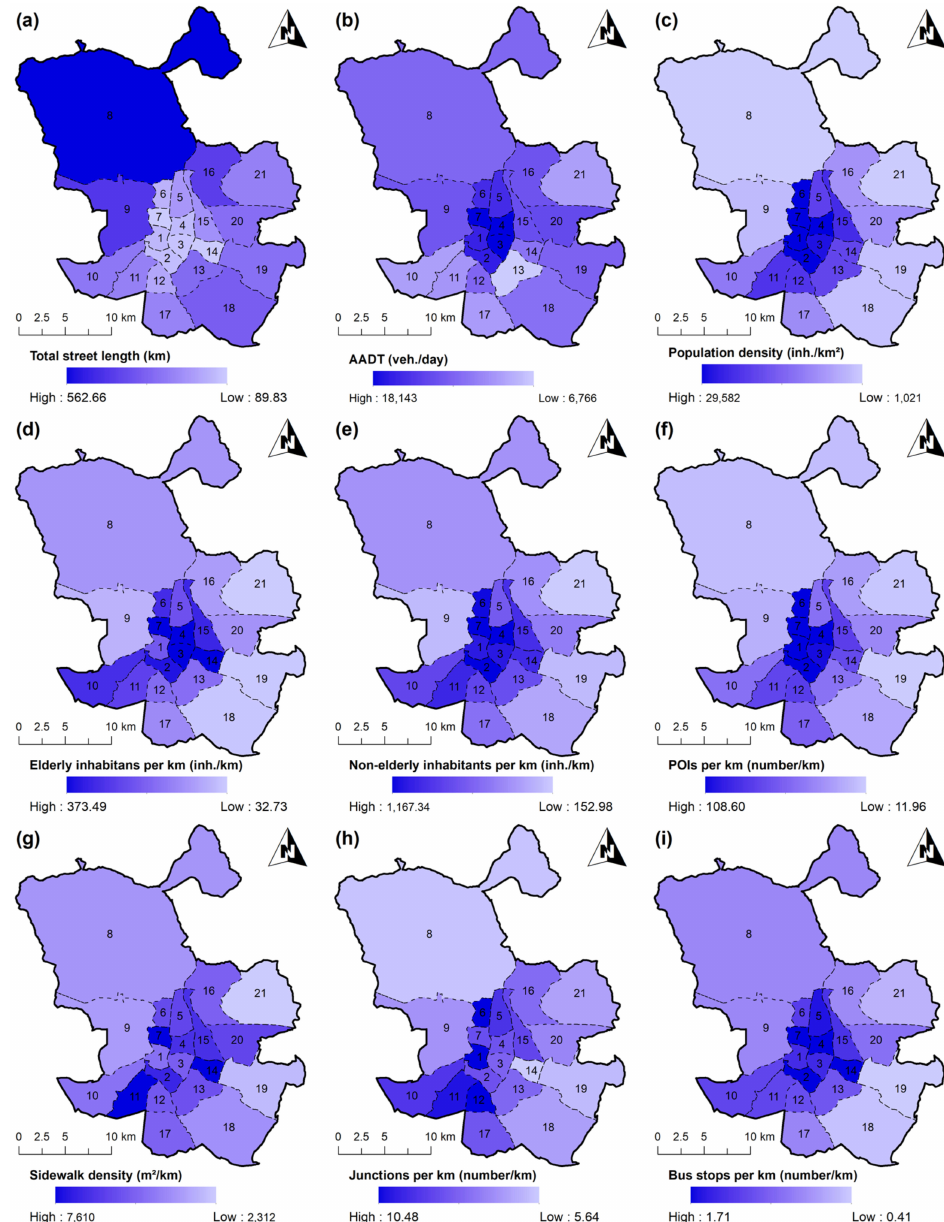
Figure 3. Spatial distribution of built environment variables in Madrid case study in 2018: ( a ) total street length, ( b ) AADT, ( c ) population density, ( d ) elderly inhabitants per kilometer, ( e ) Non-elderly inhabitants per kilometer, ( f ) POIs per kilometer, ( g ) sidewalk density, ( h ) junctions per kilometer, and ( i ) bus stops per